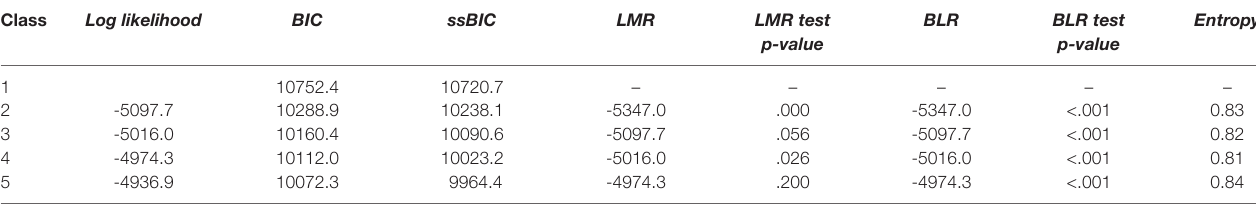
TABLE 1 | Model fit indices of latent profiles of the severities of childhood traumatic events in female patients with substance use disorders and comorbid posttraumatic stress disorders (N = 343).